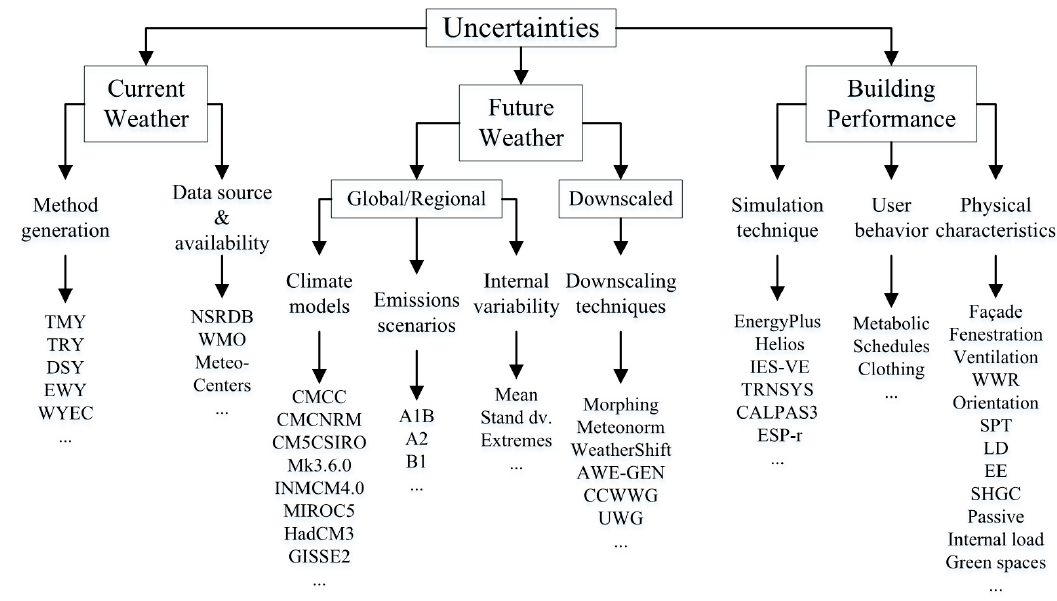
Figure 4. Summary of uncertainties in conducting building performance assessment.